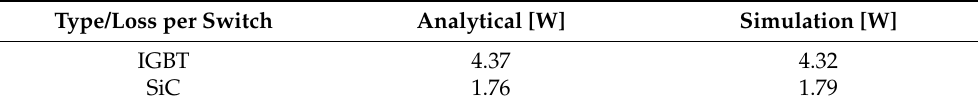
Figure 16. Compared input waveforms. Table 4. Calculated and simulated power losses in bidirectional